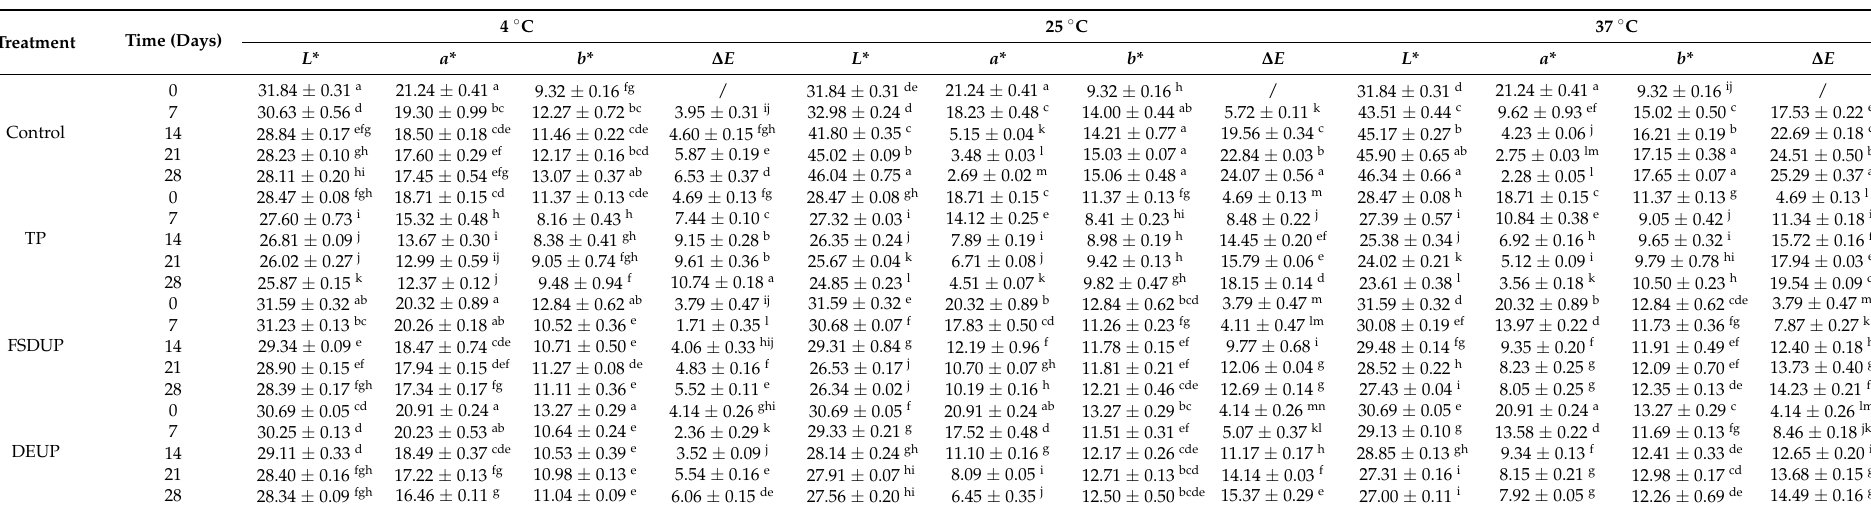
Table 3. Changes in color properties of strawberry clear juice during storage after thermal pretreatment and multi-mode thermosonication.